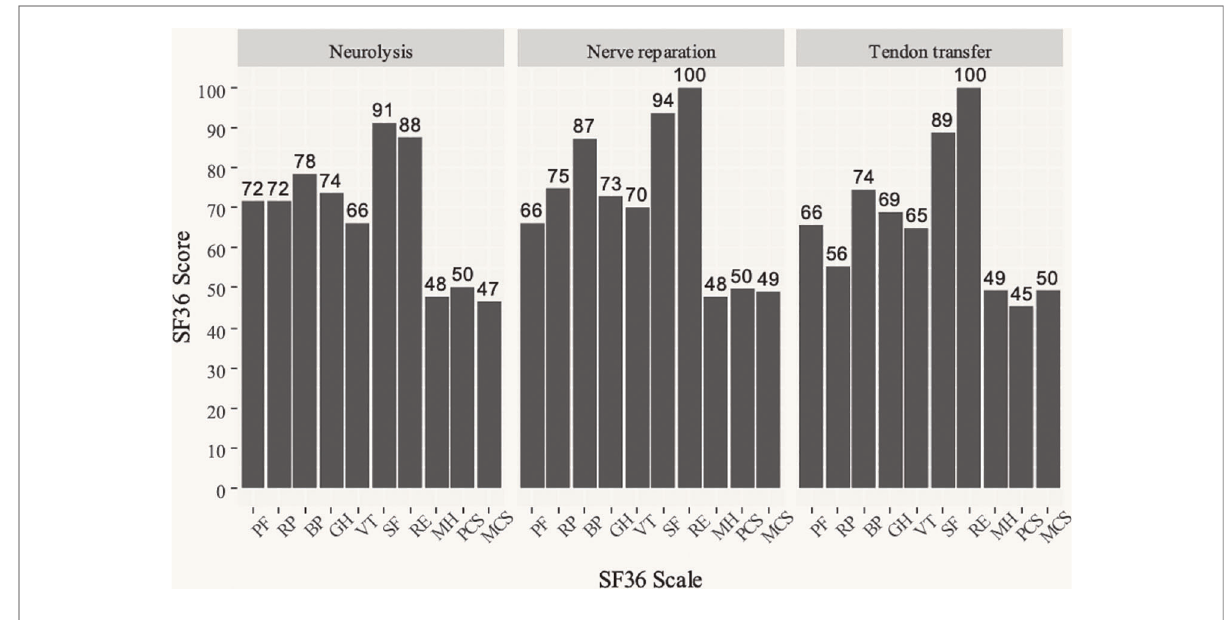
FIGURE 3 Results of the SF-36 quality of life questionnaire.